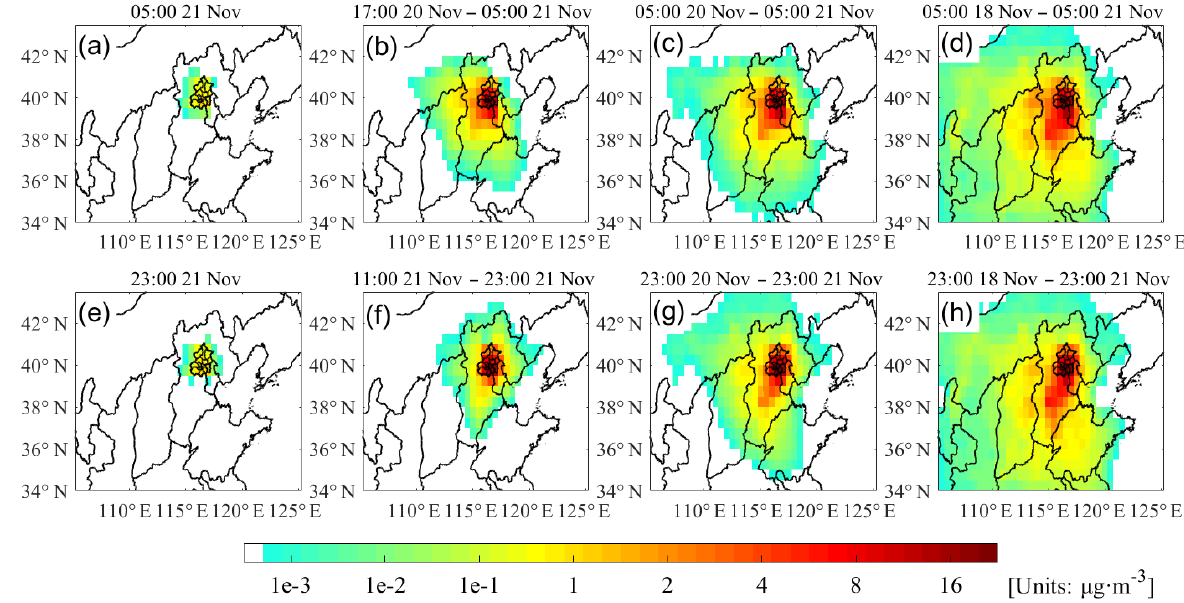
Figure 10. Time-integrated sensitivity coefficients of surface Beijing PM 2 . 5 concentration peaks to primary PM 2 . 5 sources. (a–d) 1, 12, 24, and 72h integrated sensitivity coefficients for the 05:00LT PM 2 . 5 concentration peak on 21 November; (e–h) 1, 12, 24, and 72h integrated sensitivity coefficients for the 23:00LT PM 2 . 5 concentration peak on 21